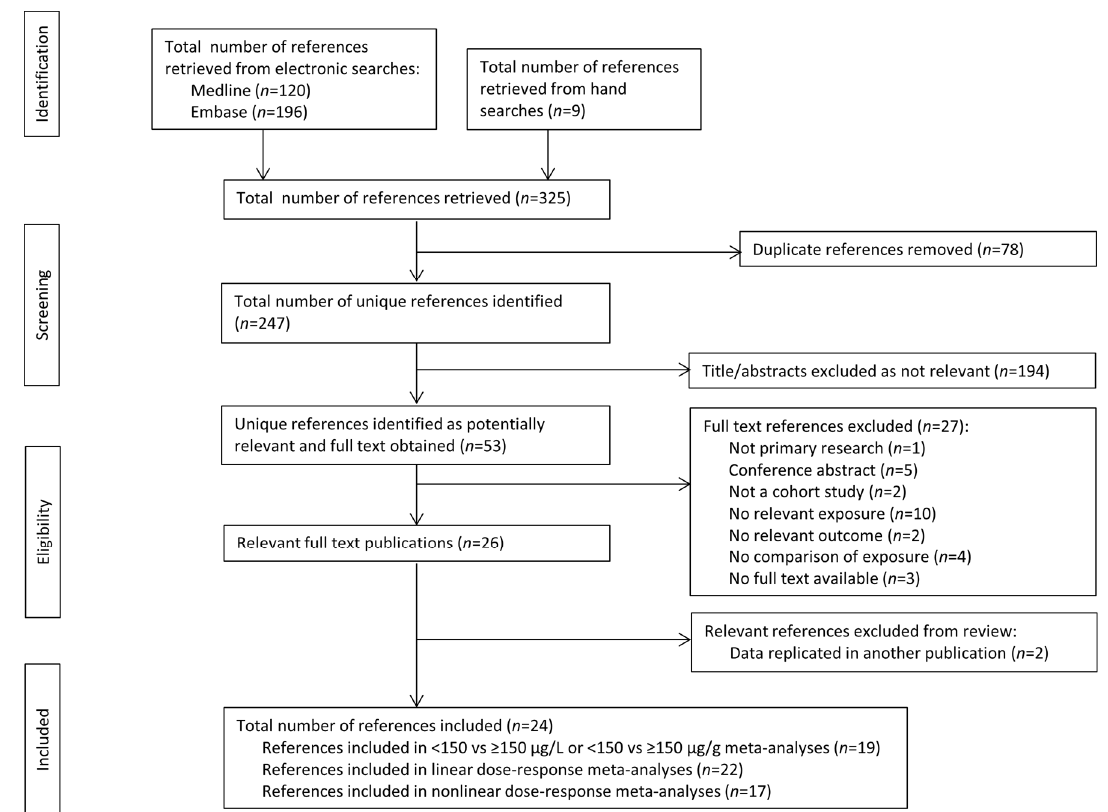
Figure 1. Article retrieval and screening process flow chart.